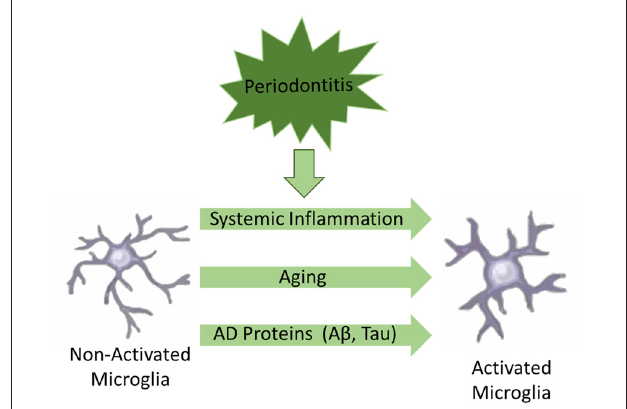
FIGURE 1 | Schematic illustration of factors associated to microglial activation in Alzheimer’s disease